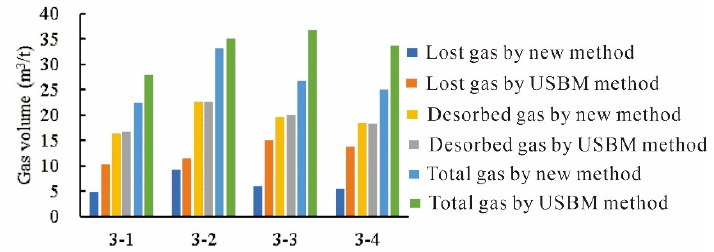
Figure 9. Comparison Results Between the New Method and USBM Method.